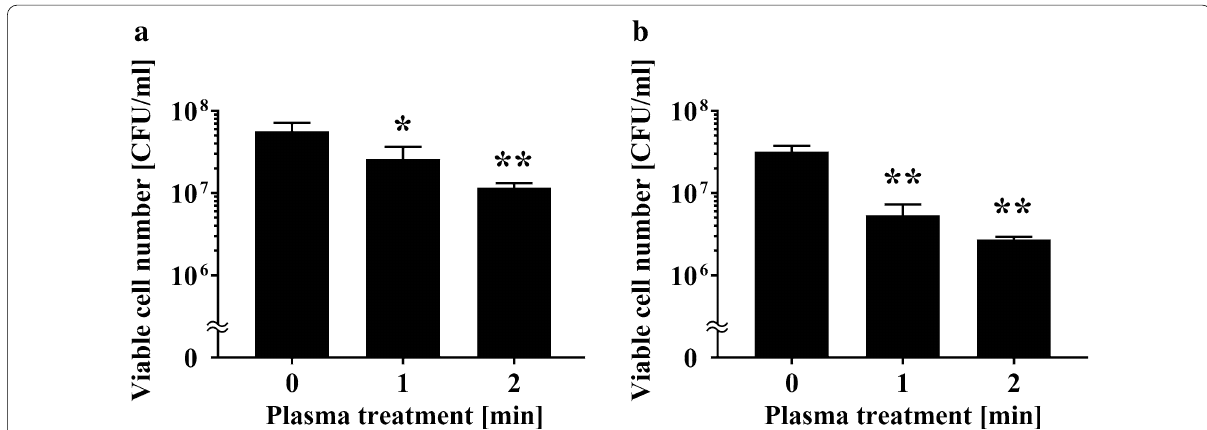
C. sinensis ) and b ‘Kawano-natsudaidai’ ( C. ×